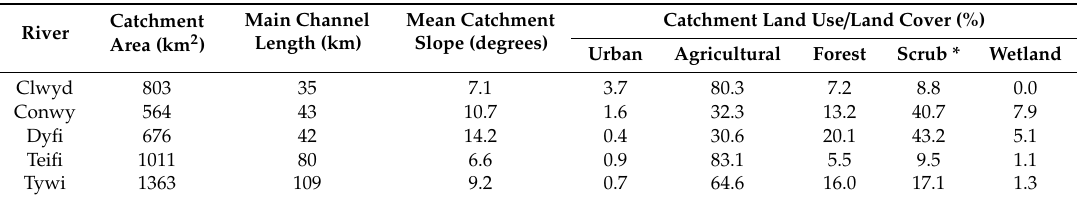
Table 1. Key study catchments details. Catchment area, main channel length, and slope data derived from Ordnance Survey provided 5 m digital elevation model; land use / land cover data derived from 2012 CORINE Landcover